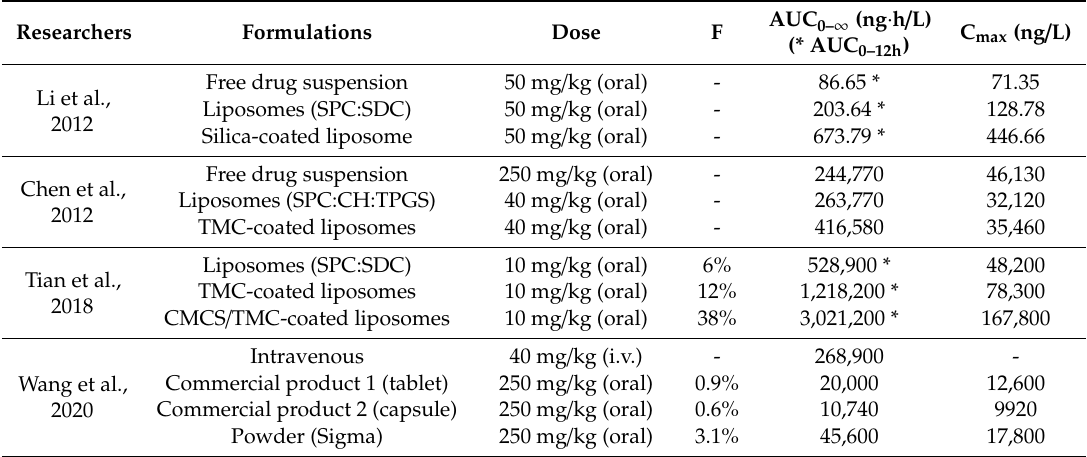
Table 4. Pharmacokinetic parameters of curcumin in rats from di ff erent